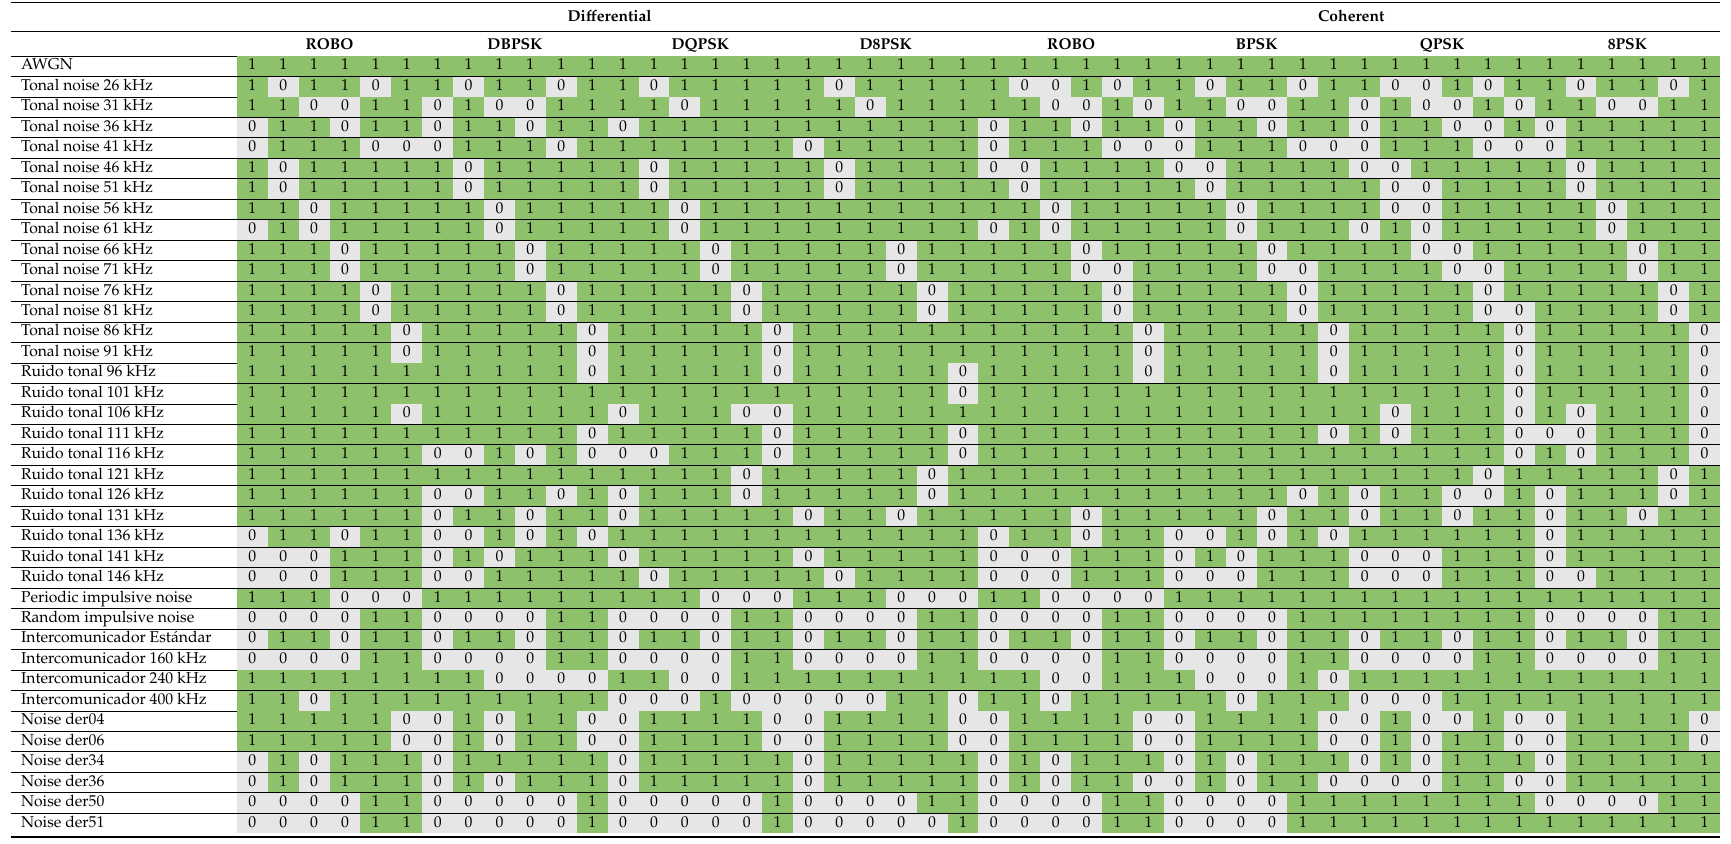
Table 8. Tone map selected per disturbance and physical